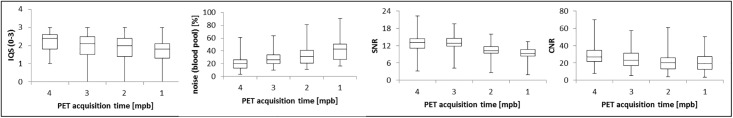
Boxplots of image quality parameter against PET acquisition time.Boxplots of the image quality score (IQS), which is defined as nondiagnostic = 0, poor = 1, moderate = 2 and good = 3; the image noise (blood pool), the signal-to-noise ratio (SNR) and contrast-to-noise ratio (CNR) against PET acquisition time in minutes per bed (mpb). Note that the image quality slightly but progressively decreases in each boxplot towards lower PET acquisition times. Also the SNR and CNR decrease with lower acquisition times, while the image noise increases.